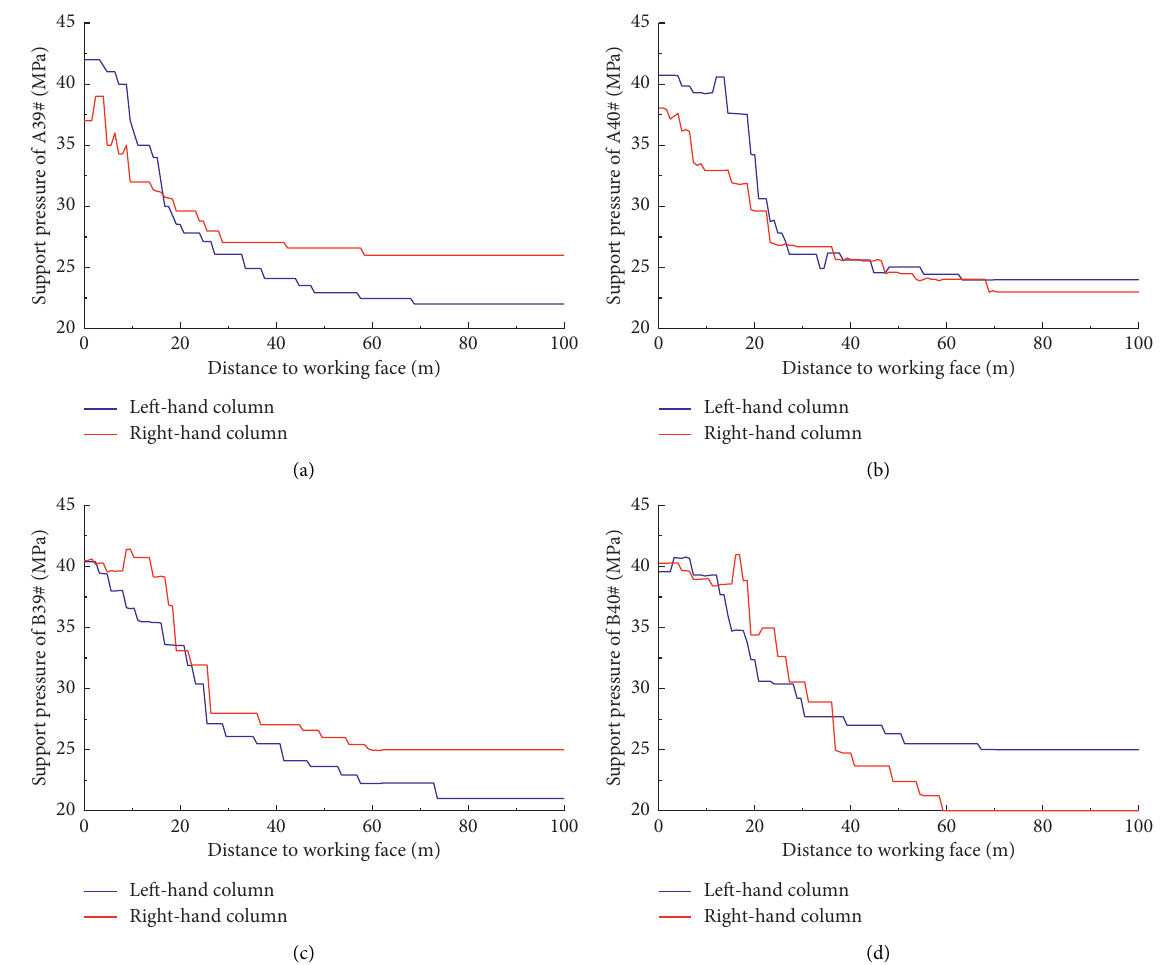
Figure 16: Monitoring results of dynamic pressure bearing supports in front of the working face.